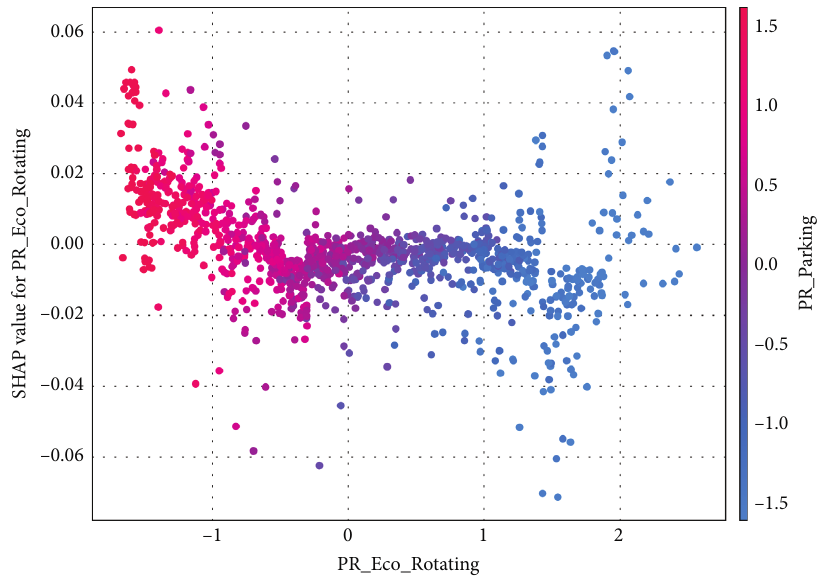
Figure 7: The global impact of economic speed on fuel